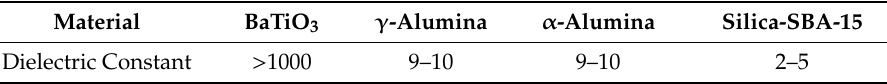
Table 1. The dielectric constant of the tested